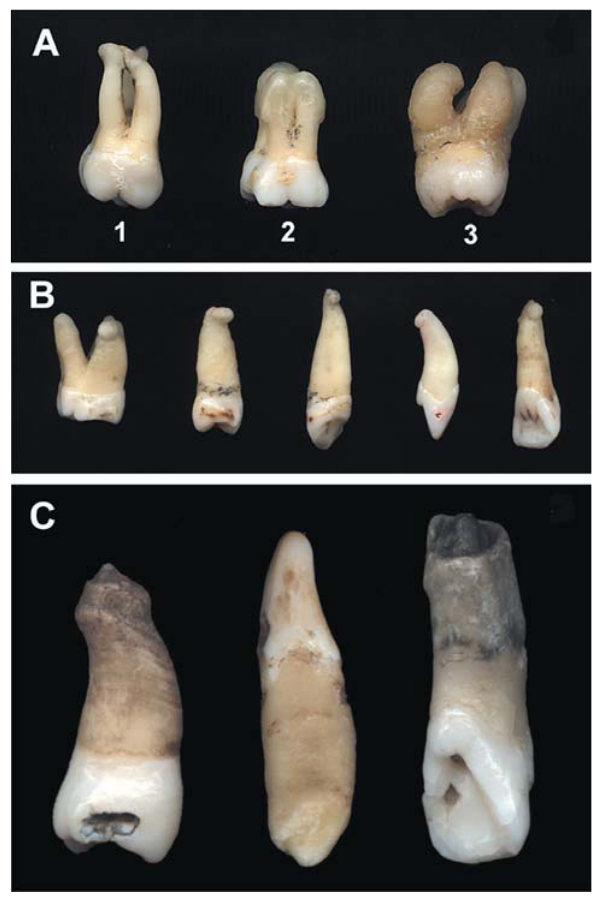
FIGURE 1- Macroscopic aspects of teeth with different types of hypercementosis. (A) Club shape hypercementosis: mild (1), moderate (2) and severe (3). (B) Focal hypercementosis. (C) Circular cementum hyperplasia hypercementosis TABLE 1- Distribution of the 28 teeth according to the tooth group, type of hypercementosis and number of examined roots